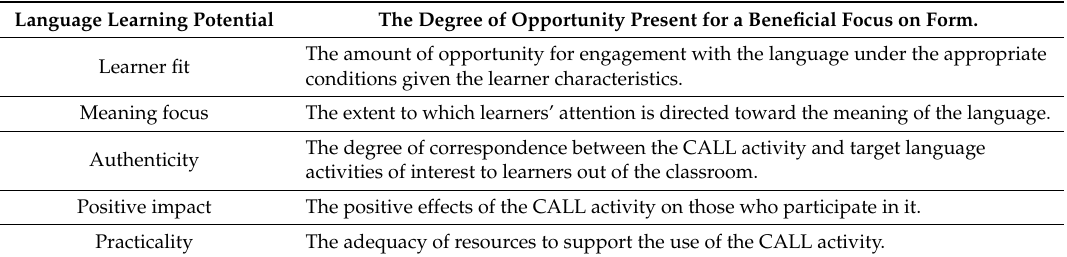
Table 1. Criteria for computer-assisted language learning (CALL) task appropriateness